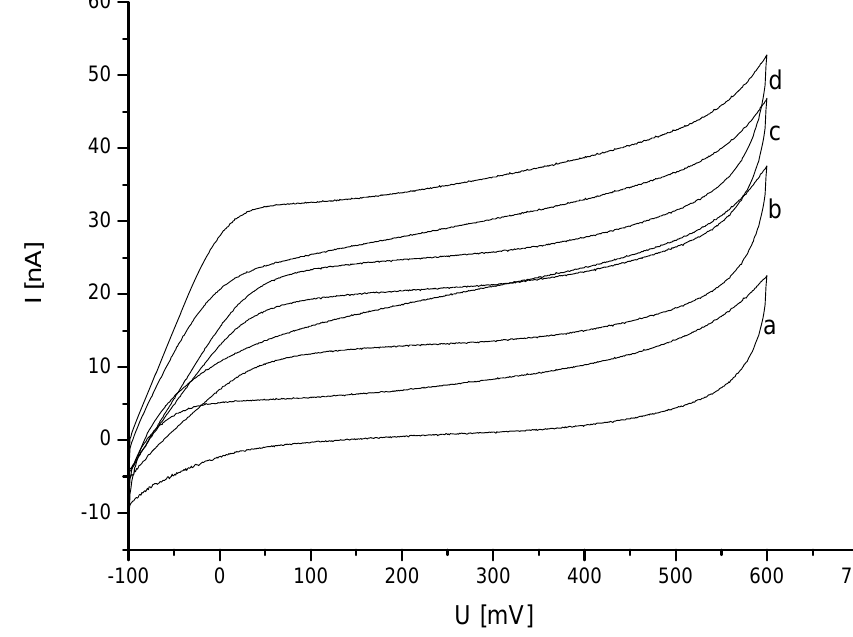
Figure 4. Au-MPA-[MWCNT-P(AMB-A)-PDA]/CDH in ( a ) 100 mM acetate buffer pH